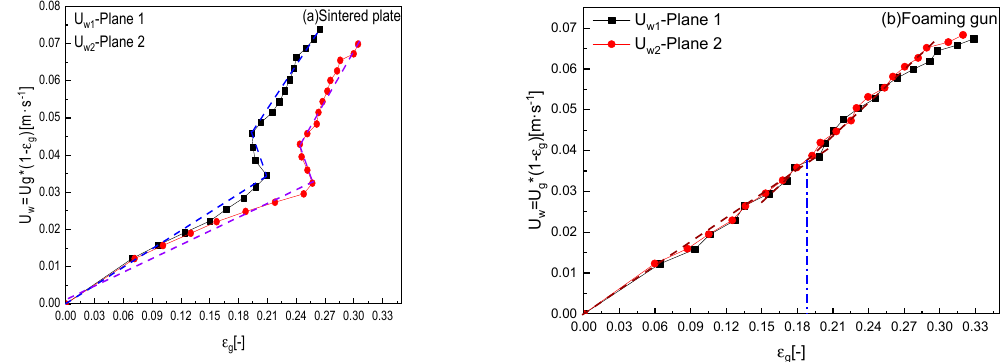
sintered plate and ( b ) foam gun.